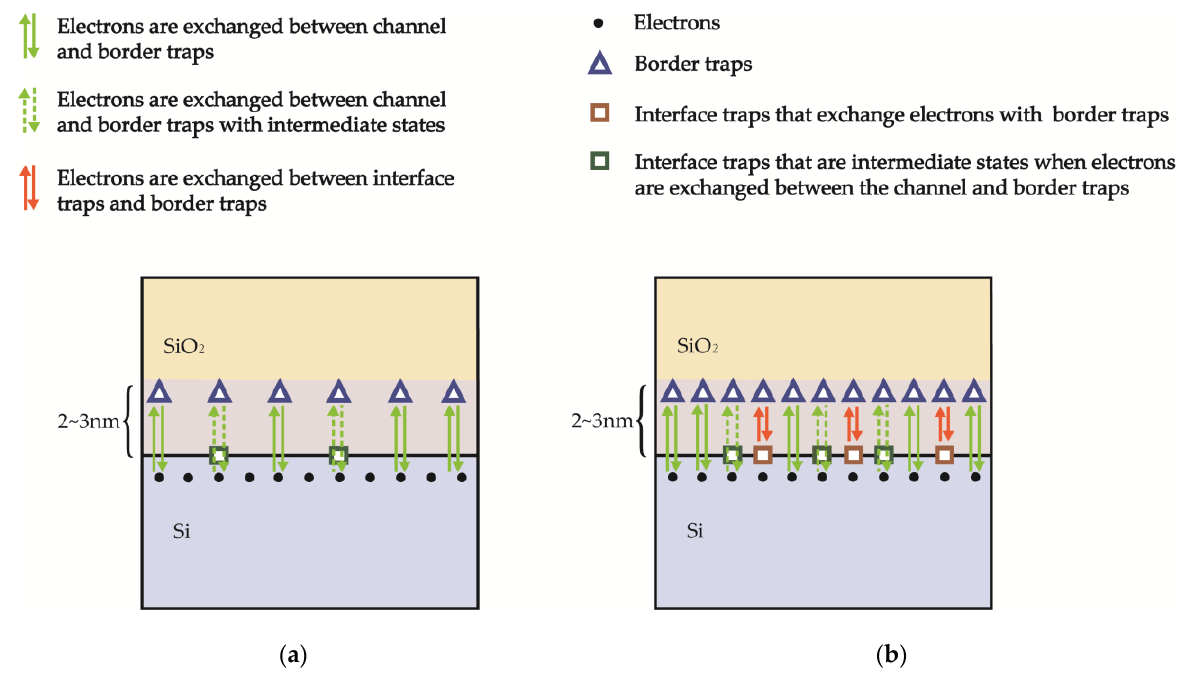
Figure 9. Illustration of low-frequency noise generation in NMOSFETs ( a ) before/under lower-dose irradiation, ( b ) under higher-dose irradiation.